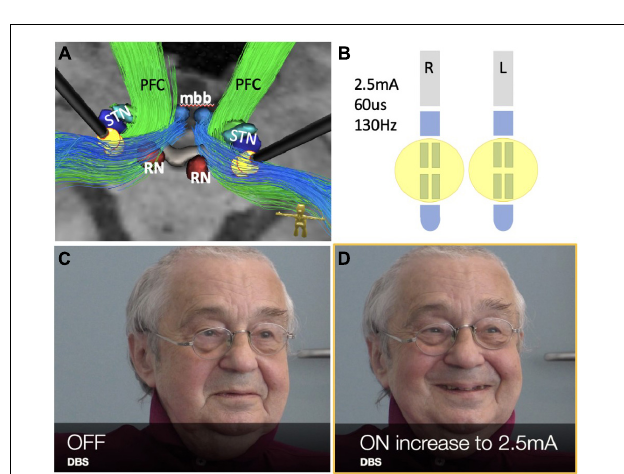
FIGURE 5 | Case #2, bilateral stimulation in the MB tracts (limiter pathways) during thalamic DBS for tremor. See also the accompanying video. (A) DBS electrode positions with stimulation pattern as shown in (B) . (B) Stimulation pattern used to evoke PAD response in postoperative phase ( see also accompanying video ). (C,D) Note initiation of PAD via bilateral stimulation (and inhibition) of limiter pathways (blue in A ). (RN, red nucleus; STN, subthalamic nucleus; mbb, mammillary bodies; PFC, PFC